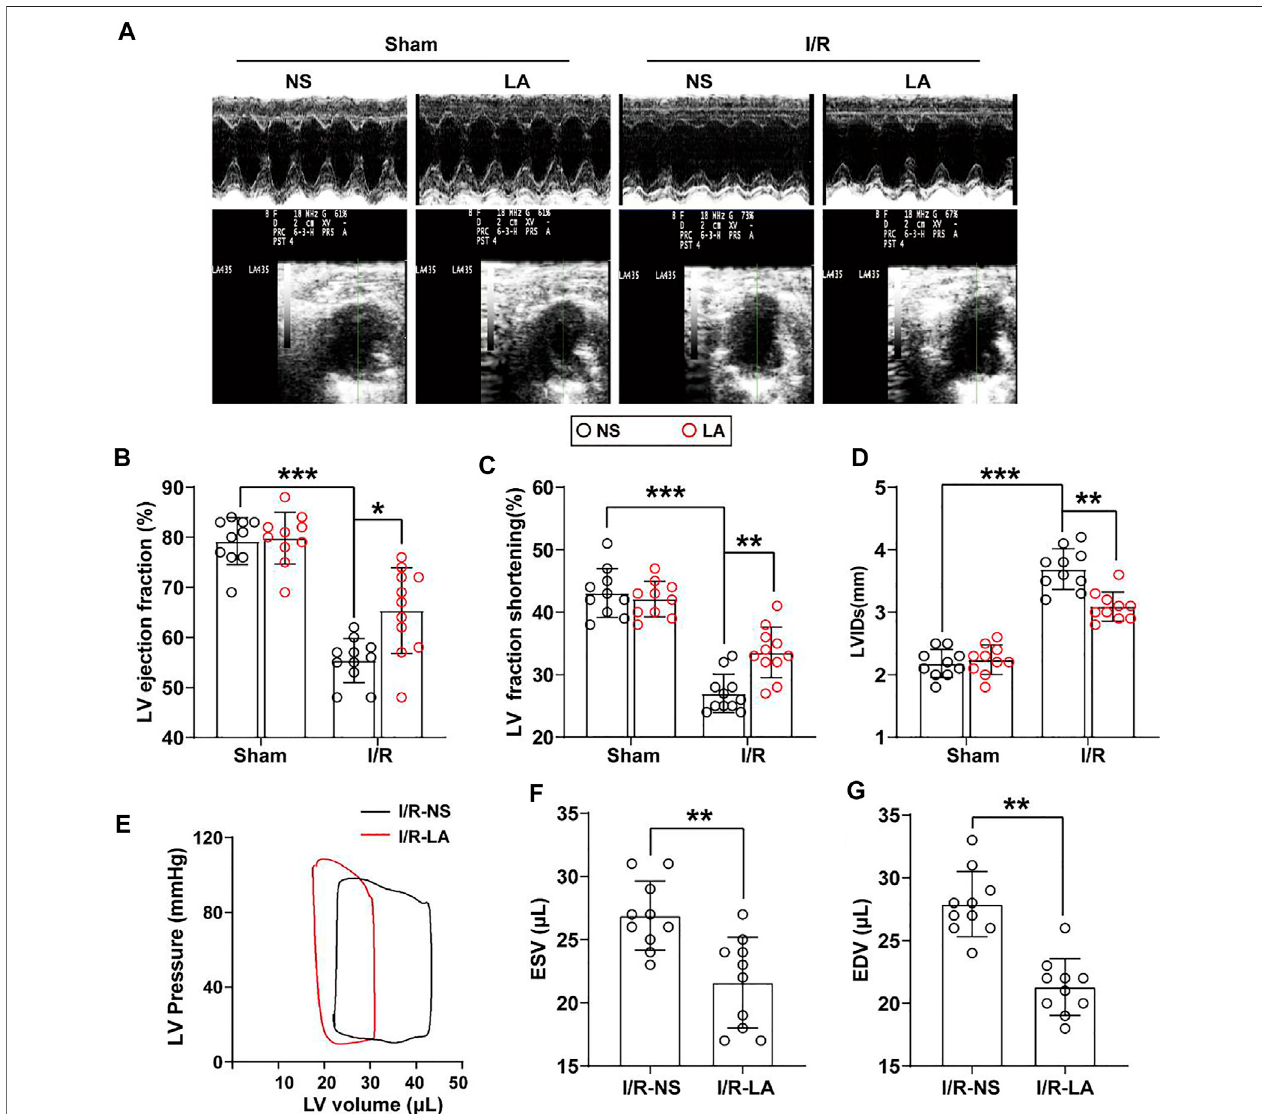
FIGURE 2 | LA improves MI/R-induced cardiac dysfunction in vivo. LA and NS pretreated mice were subjected to MI/R operation or sham (A) . Representative M-mode and B-mode echocardiography of left ventricular chamber (B – D) . Measurement of left ventricle ejection fraction (LVEF), left ventricle fraction shortening (LVFS) and left ventricular end systolic diameter (LVIDs), n (cid:1) 10 – 11 per group (E) . Representative PV loops of LA and NS pretreated mice following MI/R, and (F,G) . analysis of end systolic volume (ESV) and end diastolic volume (EDV) (n (cid:1) 10). Data are presented as the mean ± SEM, with each point representing a mouse. * indicates p < 0.05, ** indicates p < 0.01, *** indicates p <